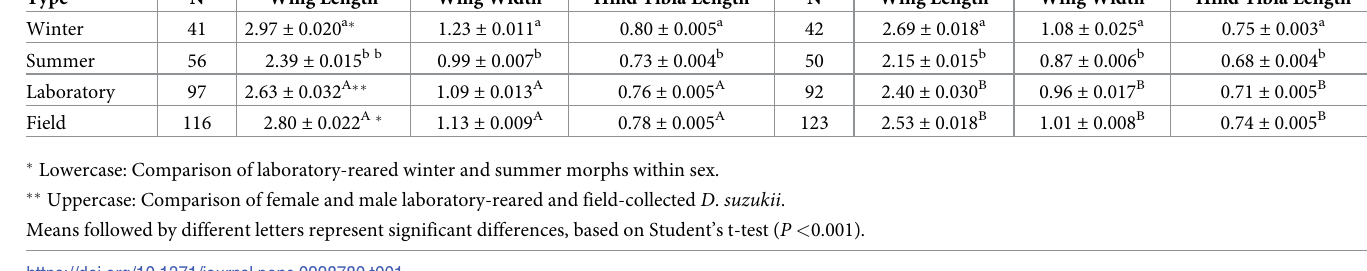
Table 1. Measurements of D . suzukii body and wing size. Mean (+/- SEM) of wing length, wing width and hind tibia length (mm) for laboratory-reared known morphs (winter and summer) of Drosophila suzukii , and field caught flies across the season. Female